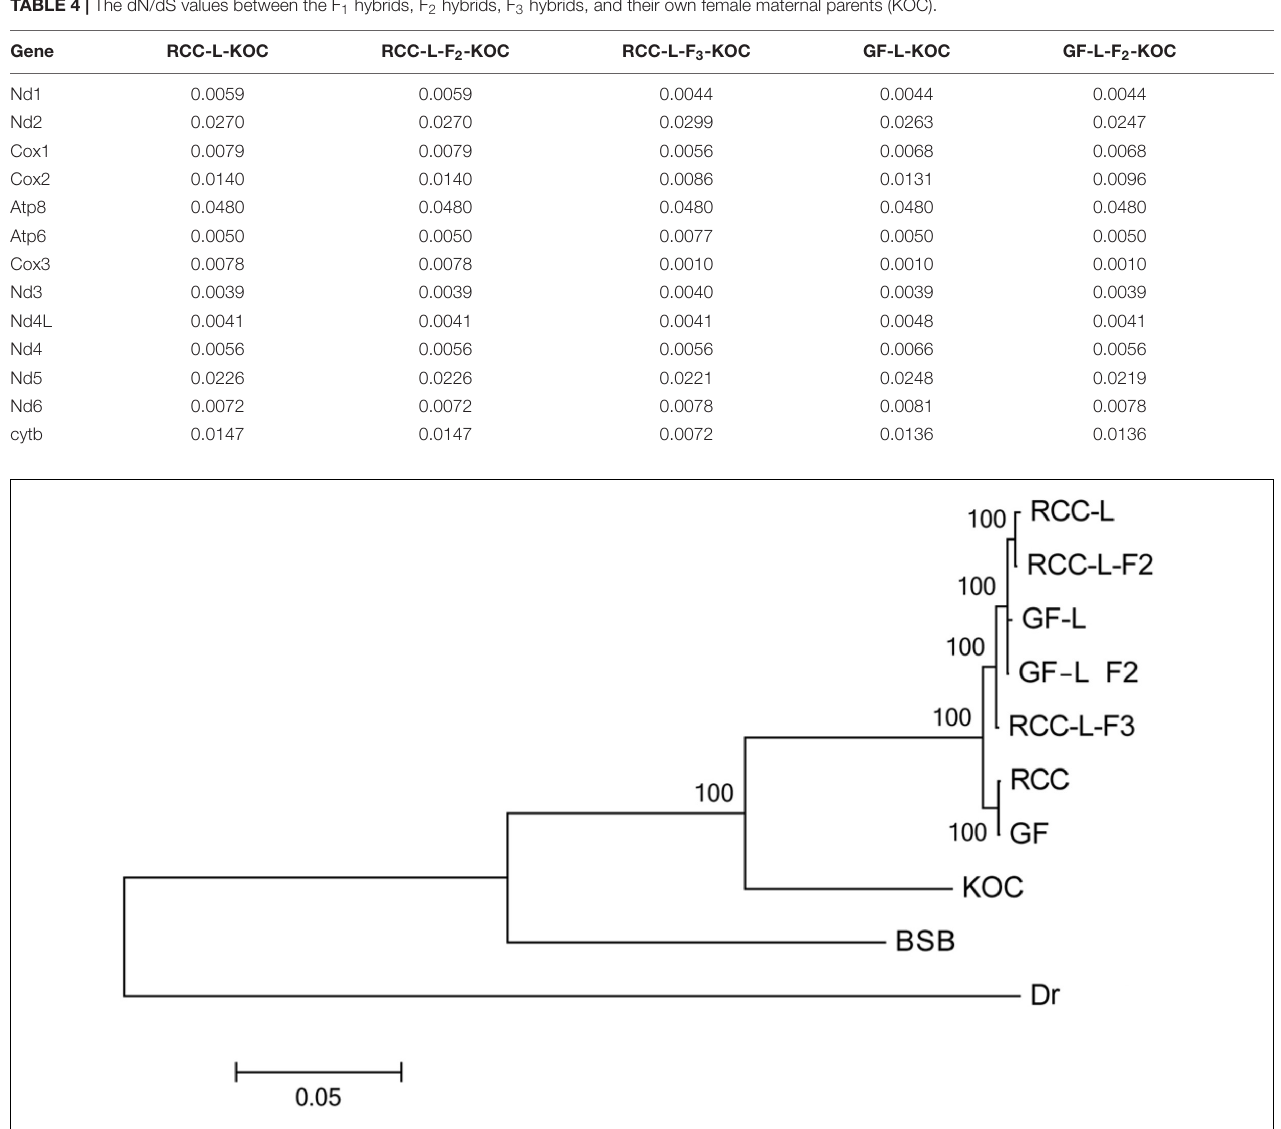
FIGURE 4 | Phylogenetic relationships among KOC, BSB, RCC-L, RCC-L-F 2 , RCC-L-F 3 , GF-L, GF-L-F 2 , RCC, GF, and Danio rerio based on entire mtDNA.